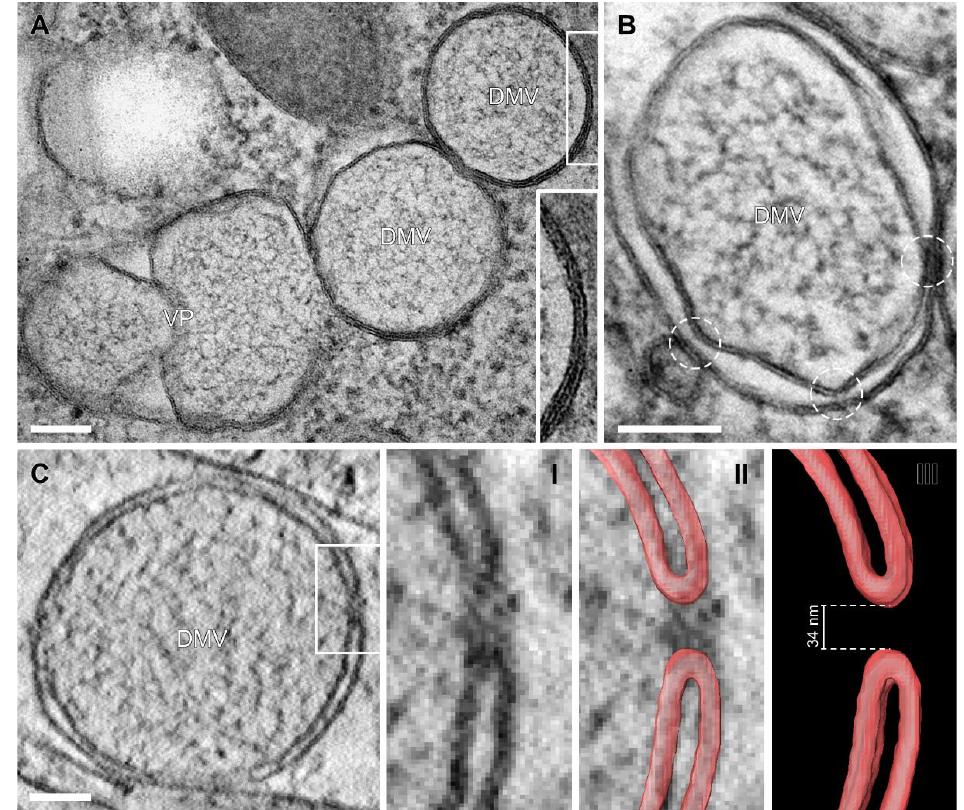
Figure 2. SARS-CoV-2 induced DMVs with inner and outer DMV membranes forming a pore structure. ( A ) TEM images of DMVs and VPs showing tight membrane apposition between inner and outer